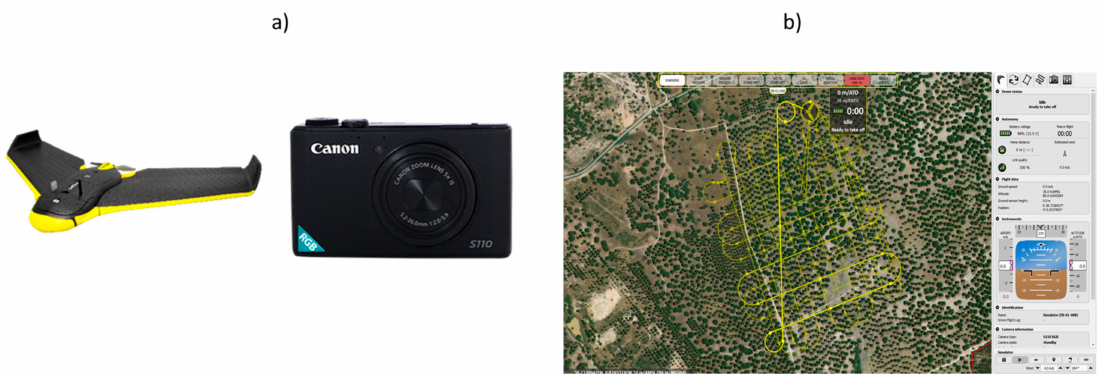
Figure 2. ( a ) Camera and UAV ( b ) Flight